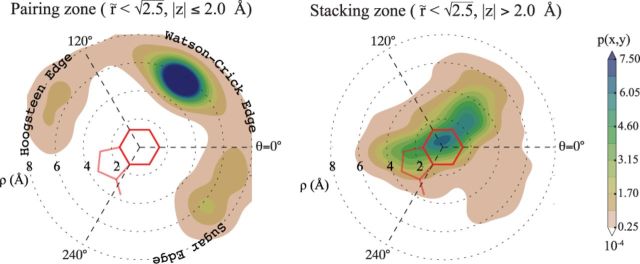
Empirical density distributions of neighboring nucleobases (\documentclass[12pt]{minimal}
\usepackage{amsmath}
\usepackage{wasysym}
\usepackage{amsfonts}
\usepackage{amssymb}
\usepackage{amsbsy}
\usepackage{upgreek}
\usepackage{mathrsfs}
\setlength{\oddsidemargin}{-69pt}
\begin{document}
}{}$\tilde{r}<\sqrt{2.5}$\end{document}), obtained by projecting points belonging to the pairing and stacking zone of Figure 1 on the θ–ρ plane. Densities are computed with a uniform binning in Cartesian coordinates and using a Gaussian kernel density estimation with bandwidth 0.25 Å. Hoogsteen, Watson-Crick and Sugar edges are indicated. The six-membered and five-membered (for purine only) rings are sketched in red.